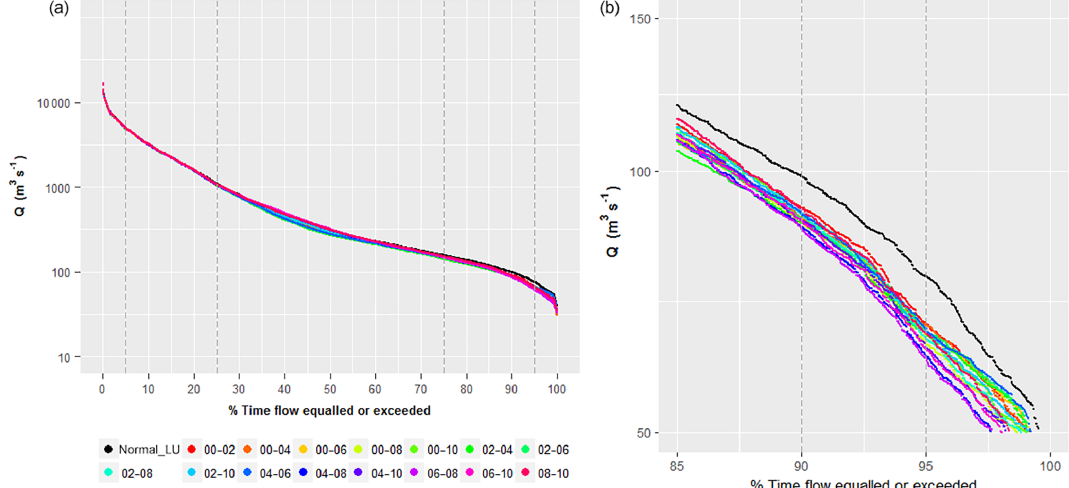
Figure 7. (a) Flow duration curves of the streamflows simulated by JULES for the Upper Ganges basin, at Kanpur barrage, for each of the 15 different future projections of land use. The meteorology was held fixed, so that only the impact of land-use change can be examined. For reference, the results of the run with the 2010 land-cover map are also plotted (normal_LU). (b) Plot focusing on the low flows, which are mostly affected by differences in the land cover.